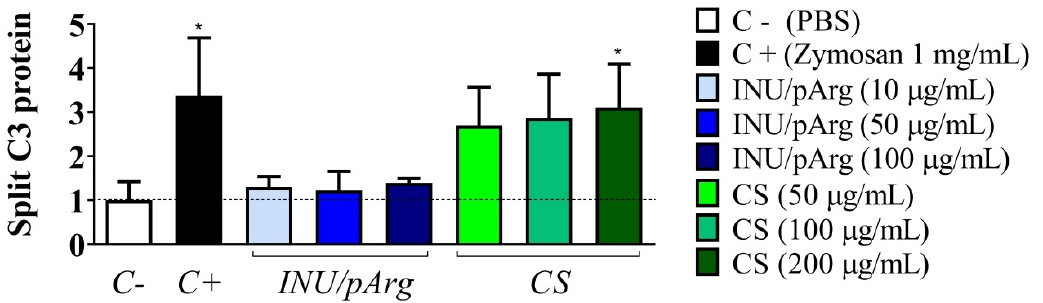
Figure 6. Relative quantification of the C3 complement factor protein degradation induced by the Imiquimod-loaded CS and INU/pArg nanocapsules at three different concentrations. CS: Chitosan, INU: Inulin, pArg: Polyarginine. Statistical significance: * P ≤ 0.05.